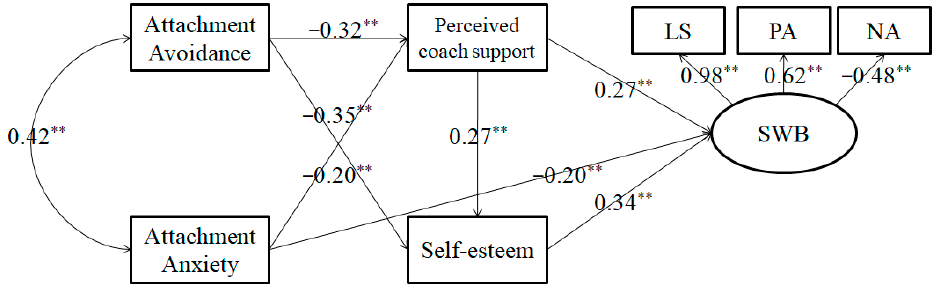
Figure 1. The final model. Note: LS = life satisfaction; PA = positive affect NA = negative affect; ** p < 0.01.